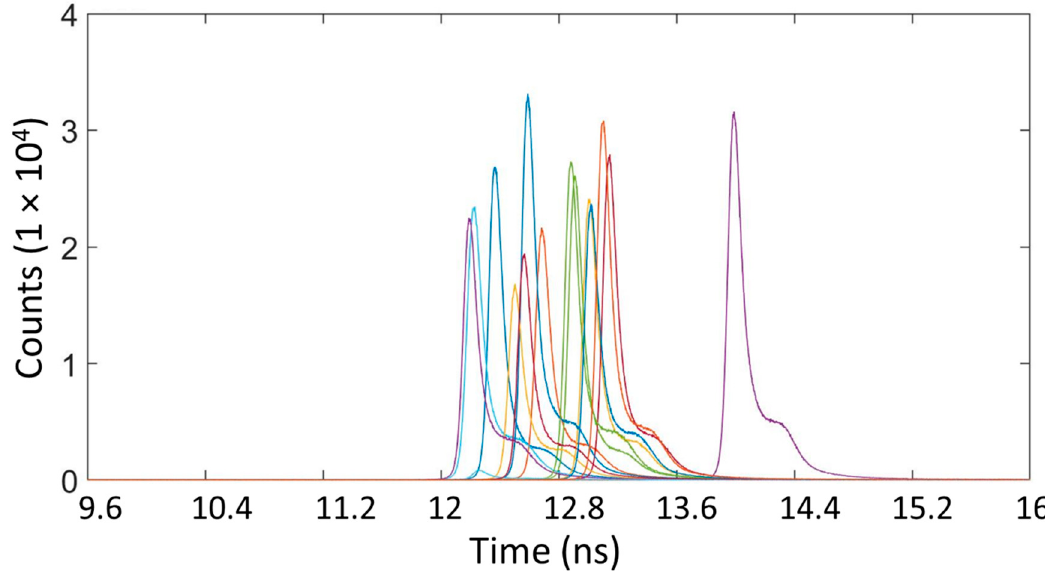
Figure 2. Instrumental response of the 16 detectors recorded in unfiltered tap water using an acquisition time of approxi- mately 40 s.